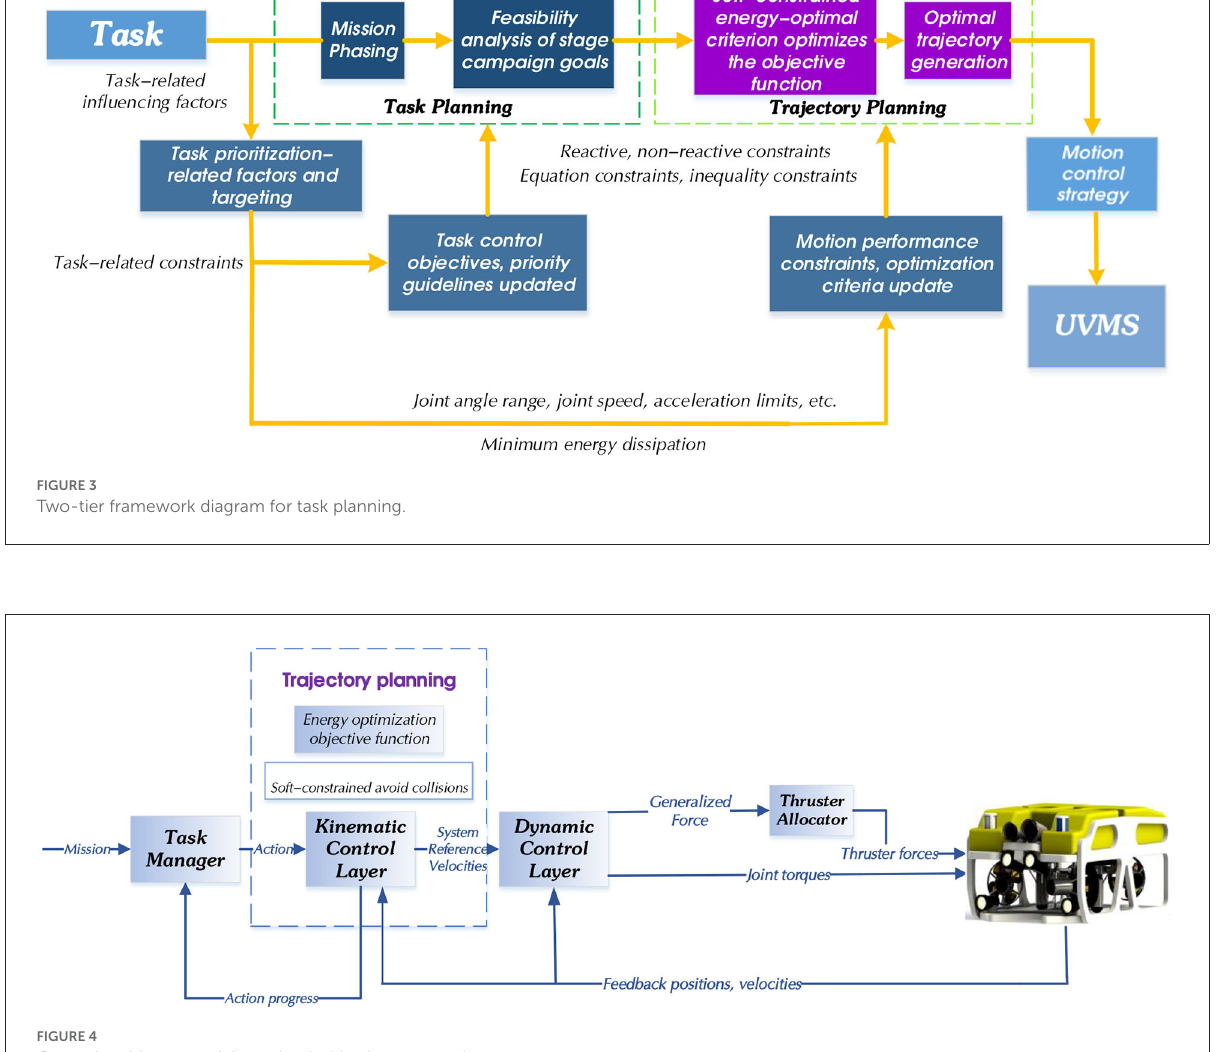
FIGURE4 General architecture of the task prioritization